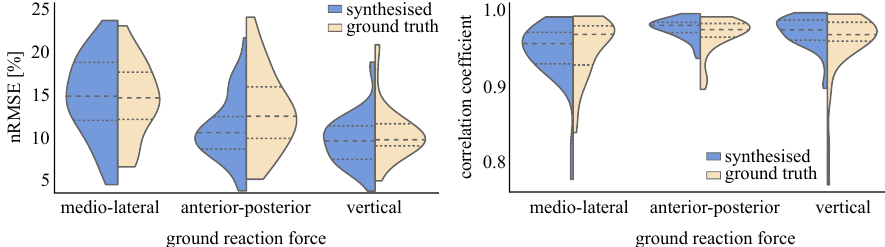
Figure 9. nRMSE ( left ) and correlation coefficient ( right ) distributions for estimated 3D ground reaction forces (95% confidence interval). The dashed horizontal lines present the median value and the 25th and 75th